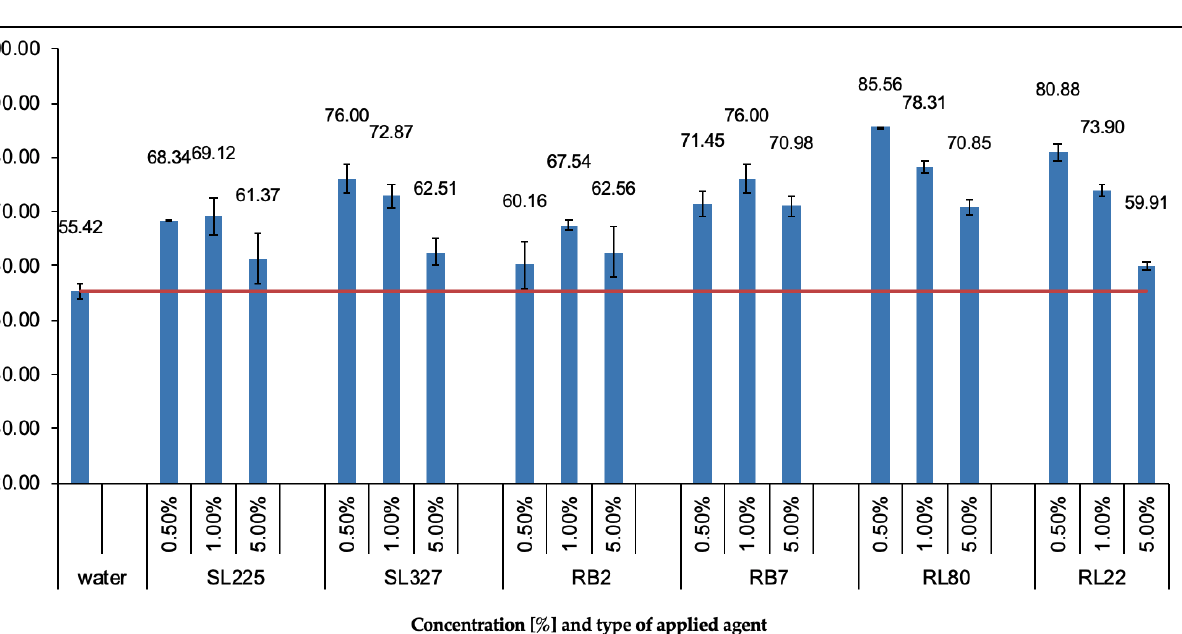
Table 2. Efficiency of mud cake removal from the roto r’s surface with new agents.